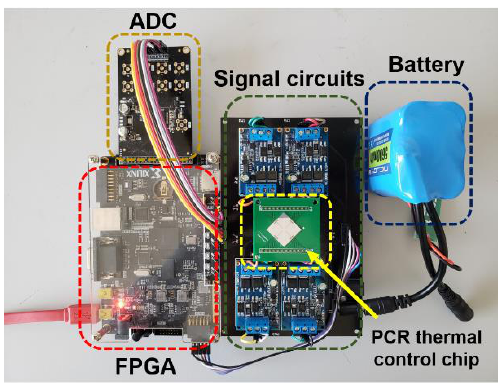
Figure 3. Photograph of the PCR thermal control chip with the external driver circuits.